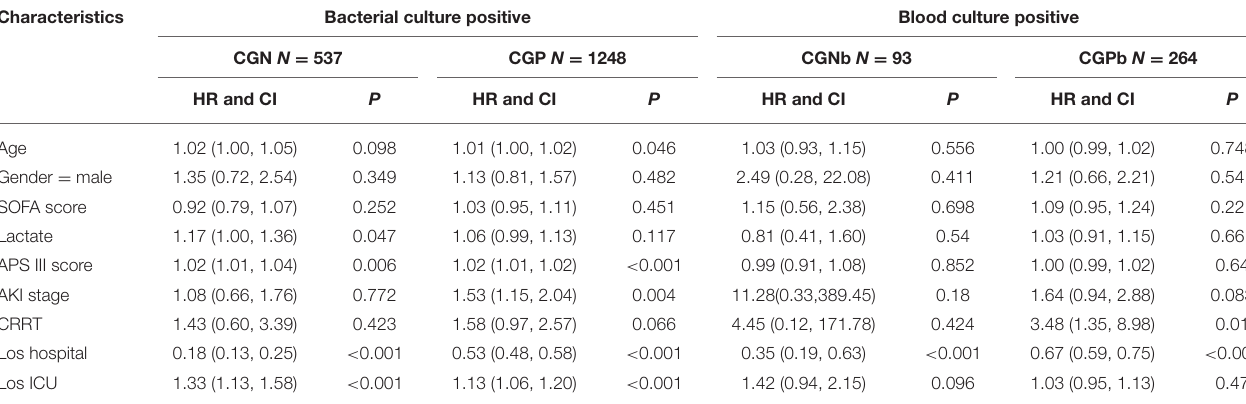
TABLE 2 | Multivariate Cox regression analysis of the correlation between variables and intensive care unit (ICU) mortality among groups.